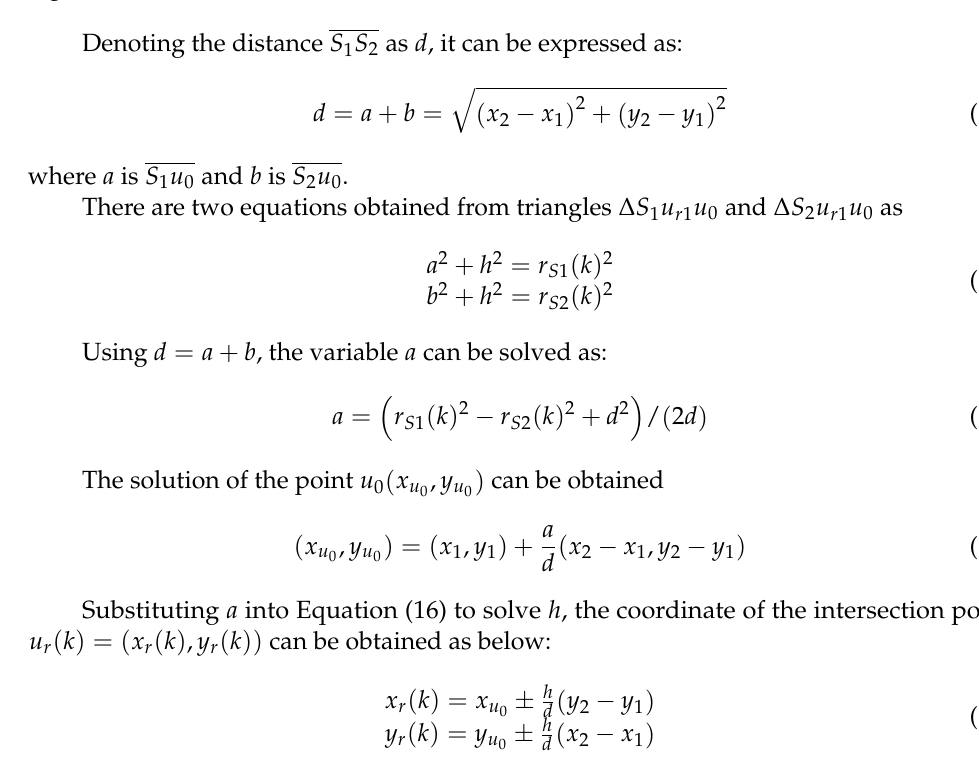
Figure 4. Intersection of two circles.